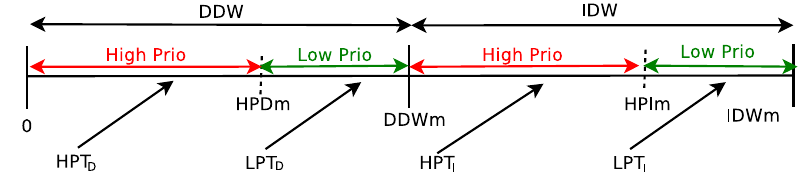
Figure 5. Defer windows for priority-based